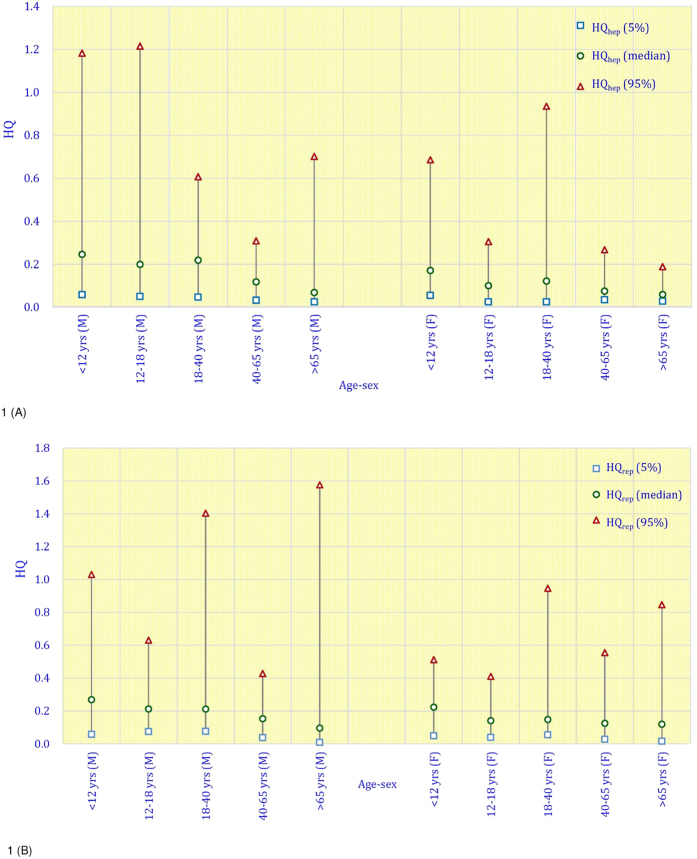
The median and 95th percentile hazard quotient (HQ) for (A) hepatic effects; and for (B) anti-androgenic effects of four phthalates in different age groups by gender based on the EFSA TDIs and USEPA RfD.